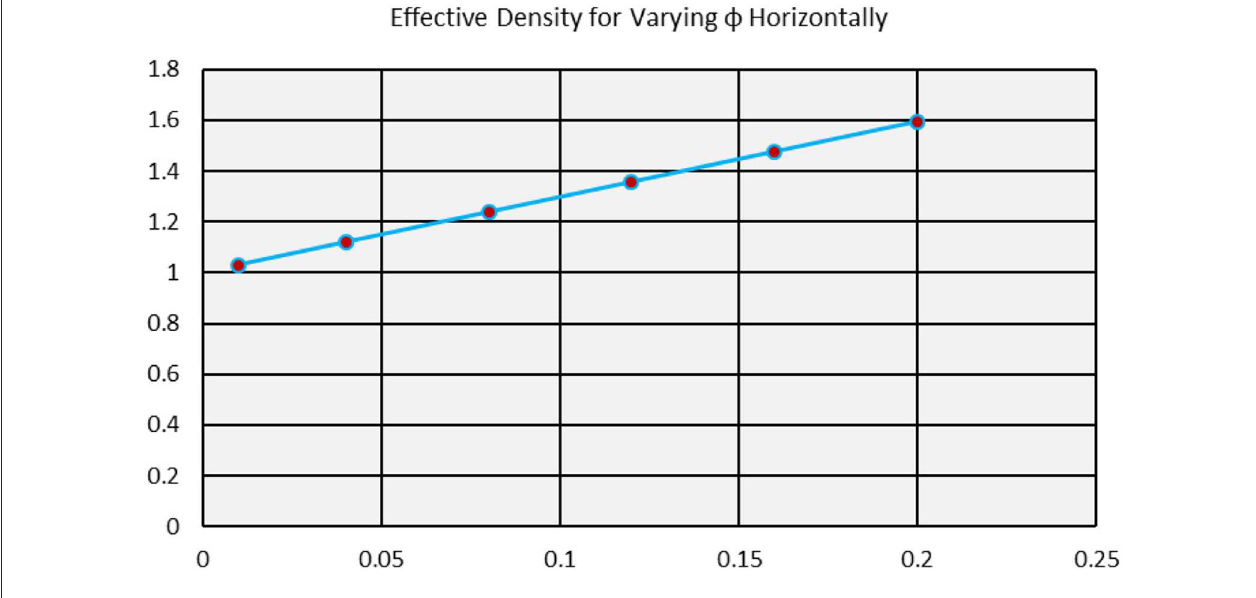
FIGURE 19 | The effects of φ on Effective density.